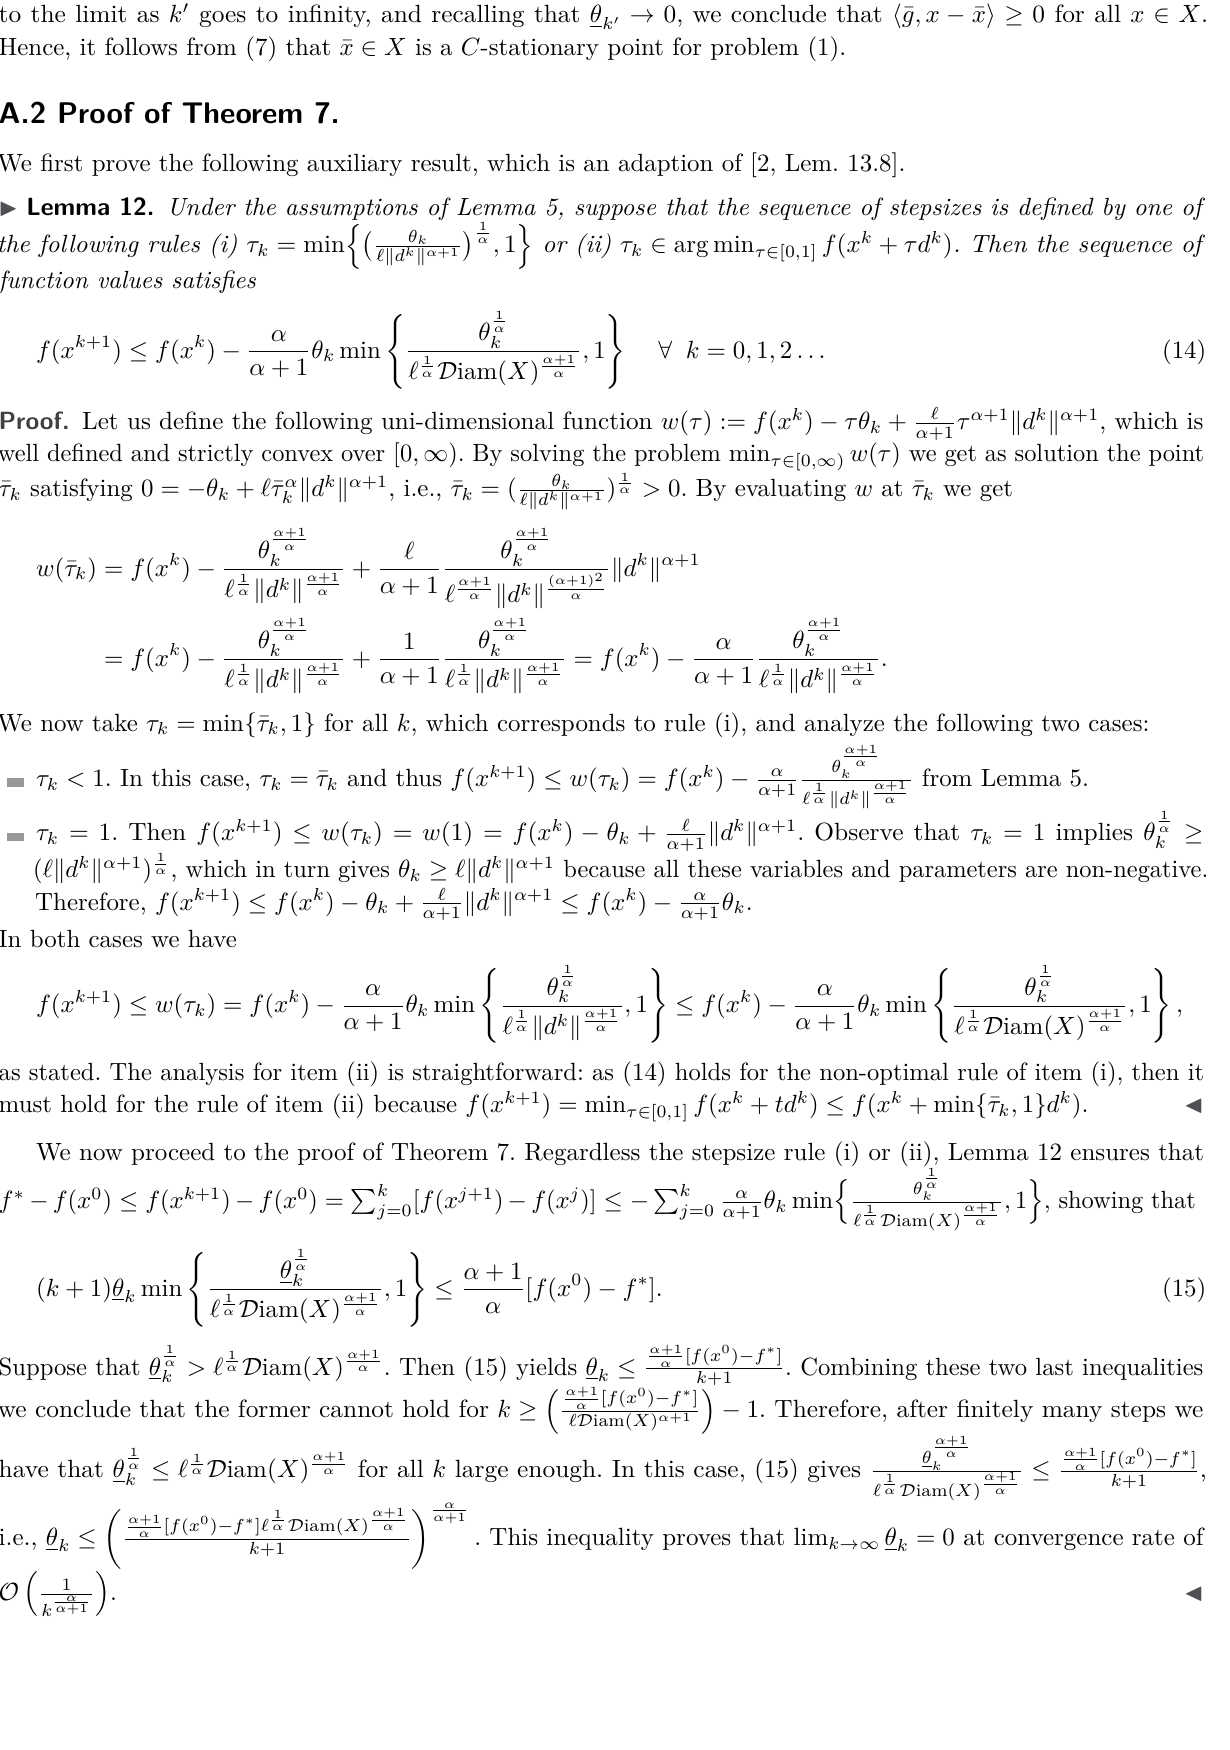
FW algorithm for minimizing upper C 1 ,α